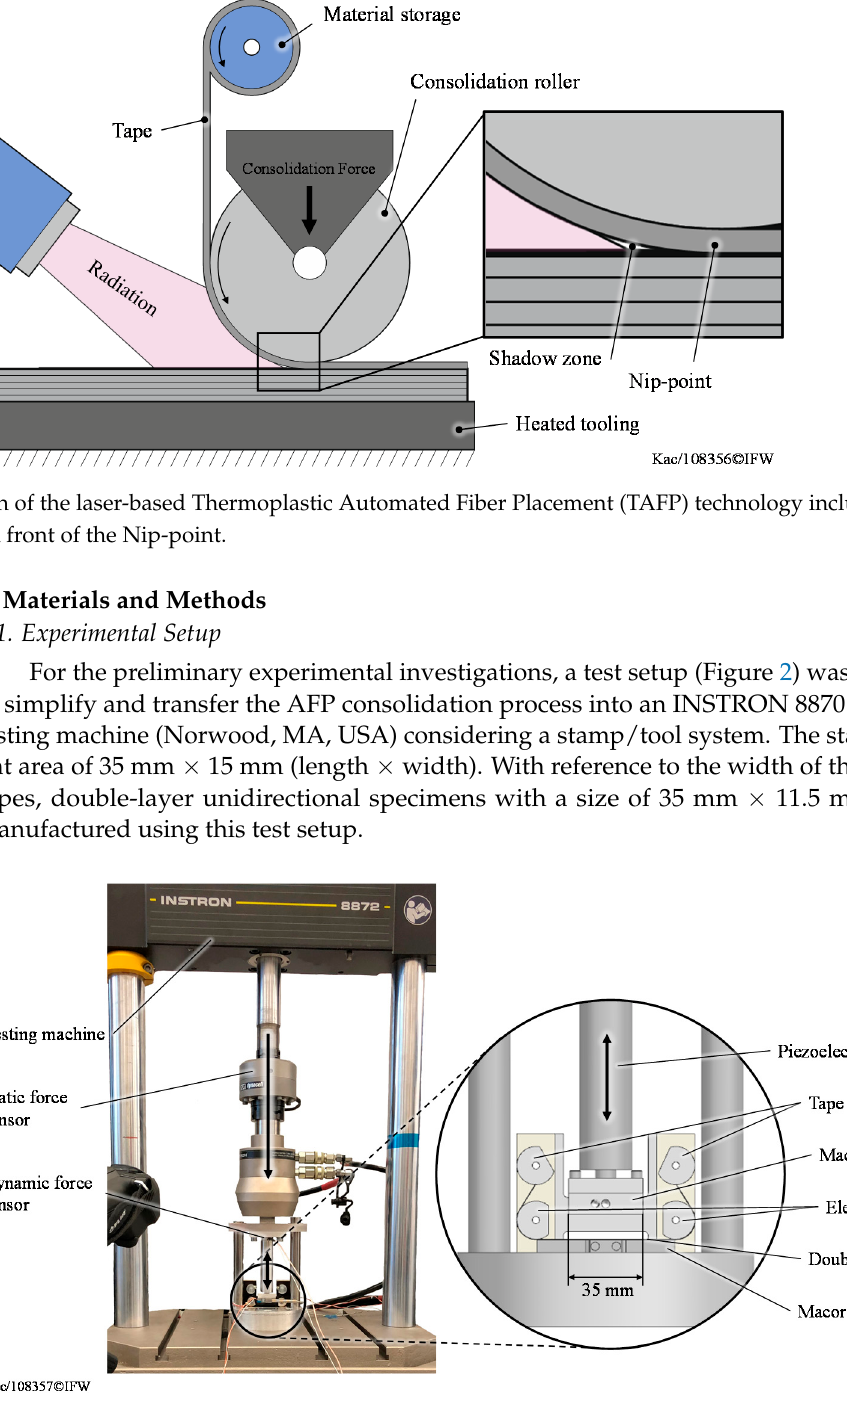
Figure 2. Test setup used for the consolidation experiments.